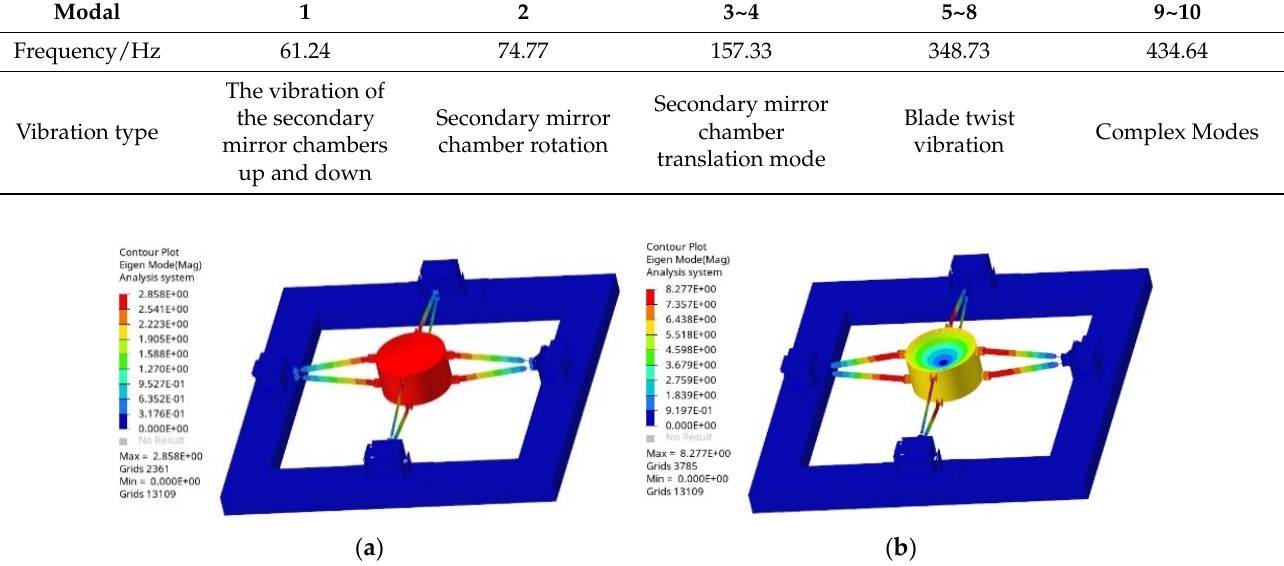
Figure 8. ( a ) First-order modal vibration diagram; ( b ) Second-order mode vibration diagram. Table 1. First tenth-order modal values of the SMAM.